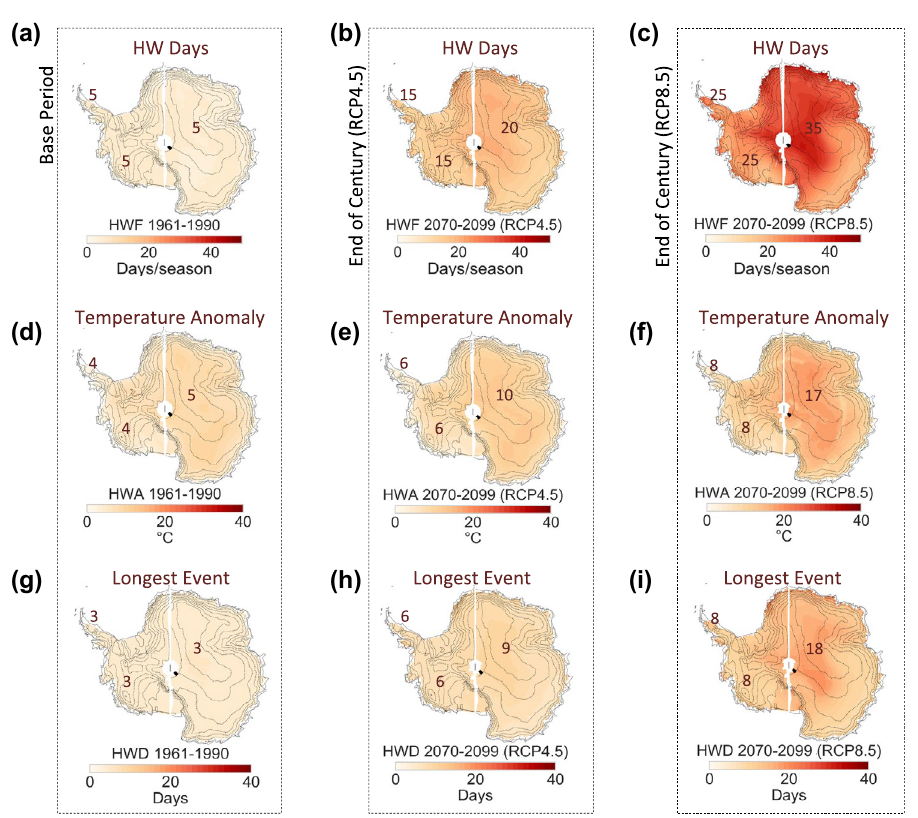
Figure 3. Summer Warming Events will become longer and more intense. Multi model mean (MMM) of summer HW metrics computed from 15 CMIP5 GCMs over the base period 1961–1990 (1st column), over the period 2070–2099 under the RCP4.5 scenario (2nd column), and over the period 2070–2099 under the RCP8.5 scenario (3rd column). ( a–c ) Number of HW days per season (HWF); ( d–f ) anomaly of the warmest day of the HWs (HWA); and ( g–i ) longest HW during a season (HWD). Plots were generated by using Python’s Matplotlib Library 44